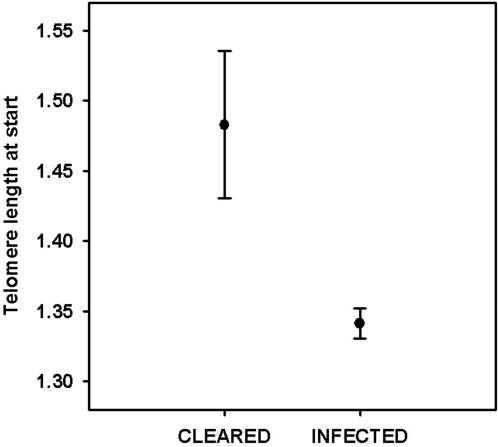
Initial telomere length and ability to resolve infection.WBC telomere lengths (mean T/S ratio±s.e.m.) at the beginning of the experiment for mice that cleared the infection (N = 6) versus mice that still harboured Salmonella (N = 11) at termination.